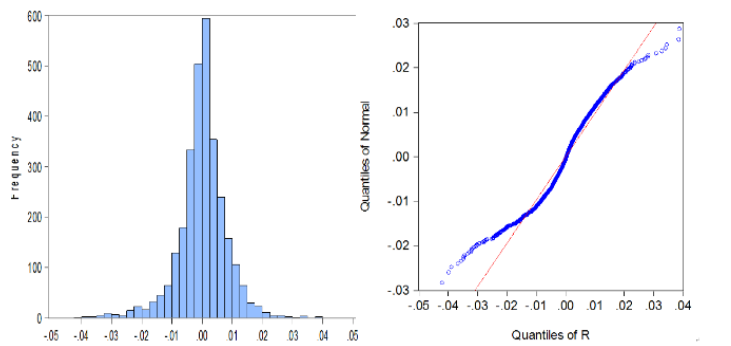
Fig. 2 Frequency Chart and Q-Q Diagram of the Yield Sequence.